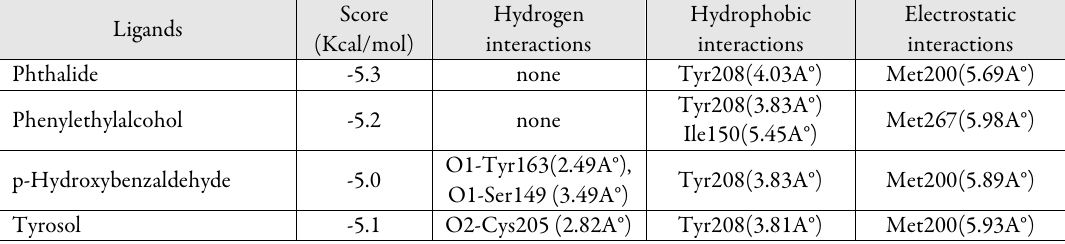
Table 2. Result of molecular docking and type of bonds between the three top-ligands and 3HNR receptor Score Hydrogen Hydrophobic Electrostatic Ligands (Kcal/mol) interactions interactions interactions Phthalide -5.3 none Tyr208(4.03A°) Met200(5.69A°) Tyr208(3.83A°) Phenylethylalcohol -5.2 none Met267(5.98A°) Ile150(5.45A°) O1-Tyr163(2.49A°), p-Hydroxybenzaldehyde -5.0 Tyr208(3.83A°) Met200(5.89A°) O1-Ser149 (3.49A°) Tyrosol -5.1 O2-Cys205 (2.82A°) Tyr208(3.81A°)